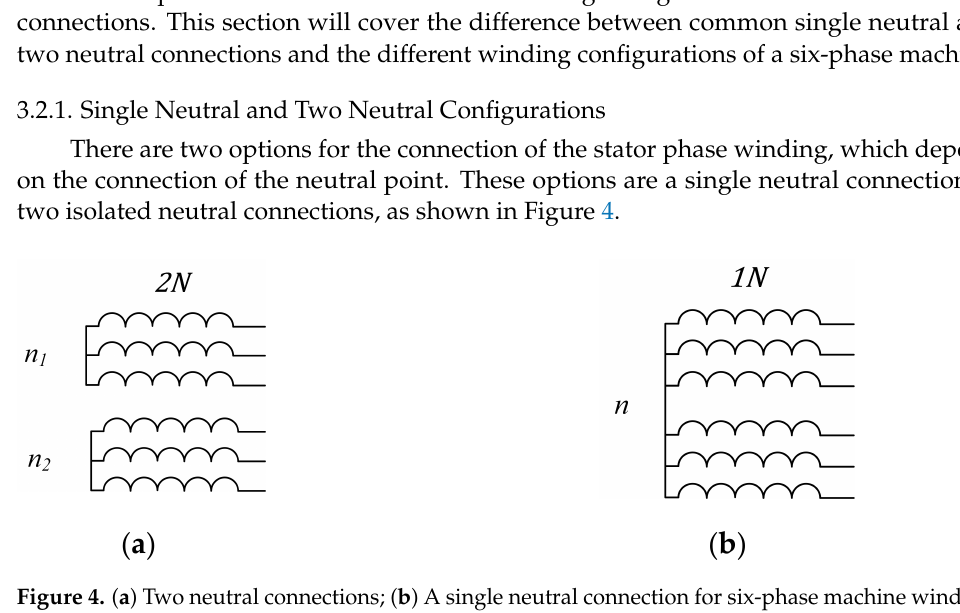
Figure 3. Five-phase stator winding for star connection.